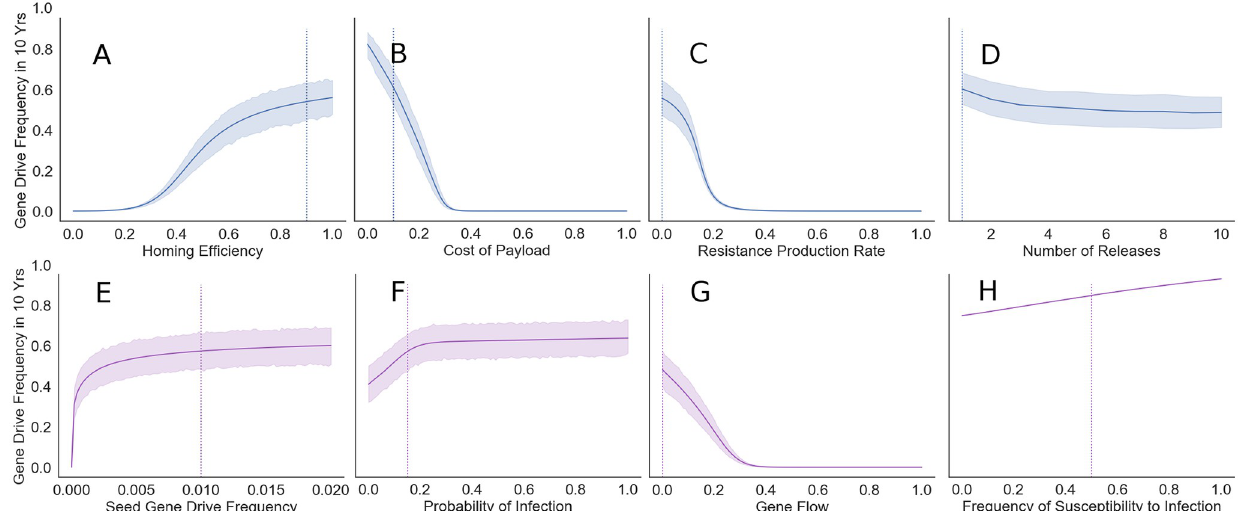
Fig 4. GDMI efficacy across a wide range of endemic conditions and genetic design. Bootstrapped 95% confidence intervals of the mean are reported on the range of results when the self-fertilization rate varies on the uniform distribution [0, 1]. Intrinsic factors to the design and release that may be modified are in the top row in blue: (A) Gene drive homing efficiency (homing success per meiotic event), (B) fecundity cost of the genetic payload (relative fitness loss), (C) rate of production of gene drive resistant mutants (resistant mutants per meiotic event), (D) number of annual GDMI partial releases needed to achieve the size of a single maximum release (e.g. 5 = 1/5th release in each of the first 5 years). Extrinsic factors that are not readily modified are in the bottom row in purple: (E) seed frequency (i.e. proportion introduced in a single release at t = 0) of the gene drive engineered snails in the population, (F) the probability a susceptible snail is infected in a generation, (G) bidirectional gene flow as the proportion of the focus population that is replaced by an external source each generation, and (H) starting frequency of snails susceptible to infection in focus the population. Because the frequency of the susceptible genotype is a function of selfing rate, bootstrapping is not appropriate for panel H. Vertical dotted lines depict the default parameter values used in the other figures. Note that the solid line represents a mean across uniformly distributed selfing values, σ 2 [0, 1], rather than the predicted results at σ = 0.5.